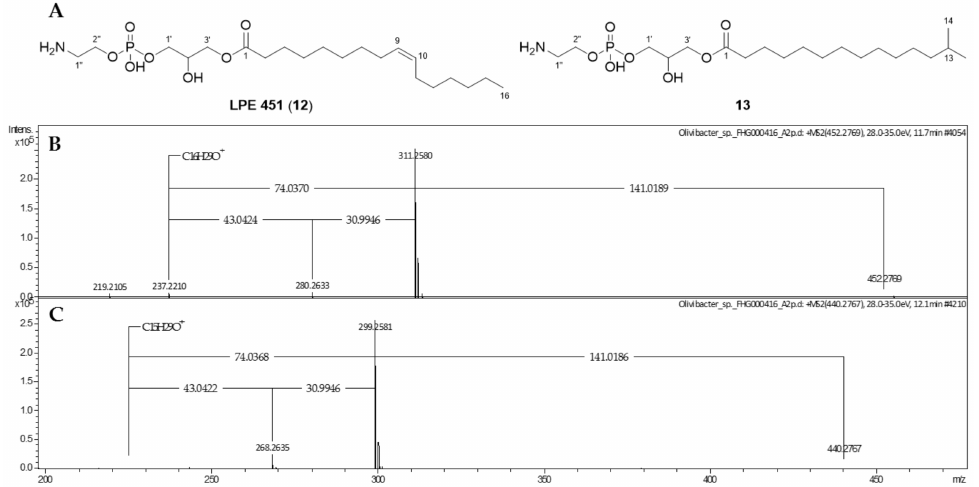
Figure 5. Chemical structures ( A ) and MS/MS spectra of LPE 451 ( 12 , B ) and its new derivative ( 13 , C ), isolated from Olivibacter sp.